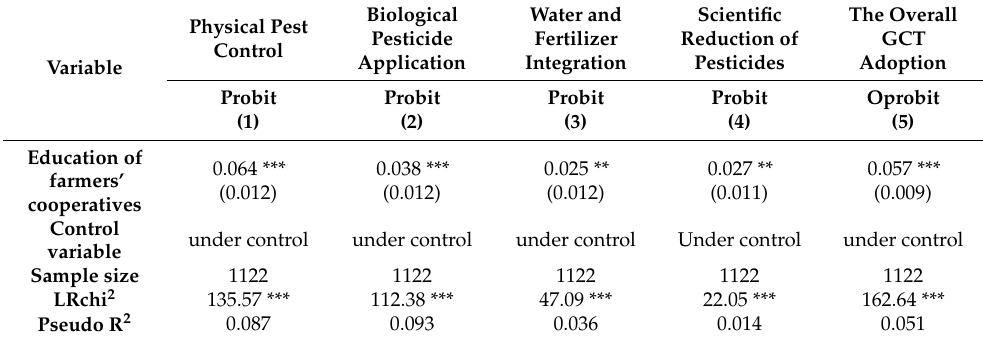
Table 8. Sample stability tests.